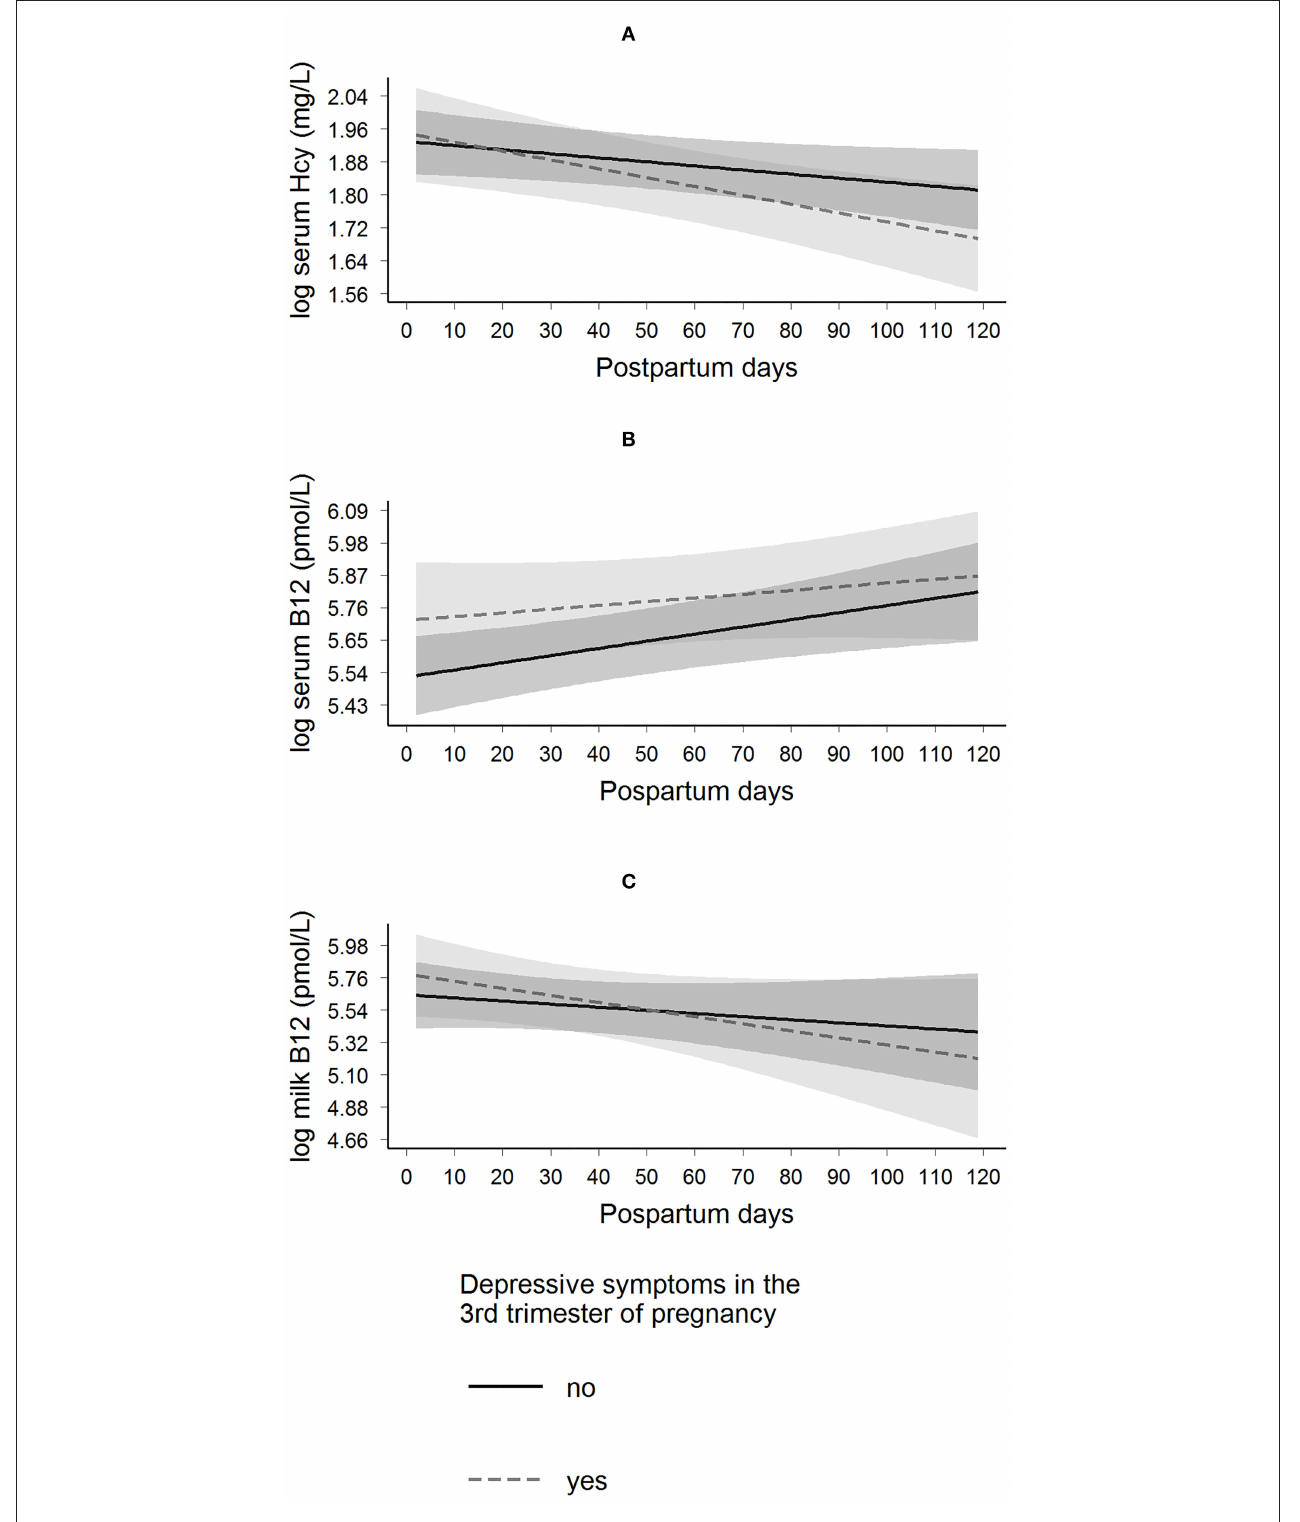
FIGURE 2 | Longitudinal predictions of maternal serum homocysteine, serum B-12, and milk B-12 concentrations according to the presence of depressive symptoms in the 3rd trimester of pregnancy in Rio de Janeiro, Brazil. β Coefficient interactions ( β interaction ) and standard error (SE) were estimated. These parameters were used to evaluate the changes of having depressive symptoms on the trajectory of each biological sample. Depressive symptoms were assessed by the Edinburgh